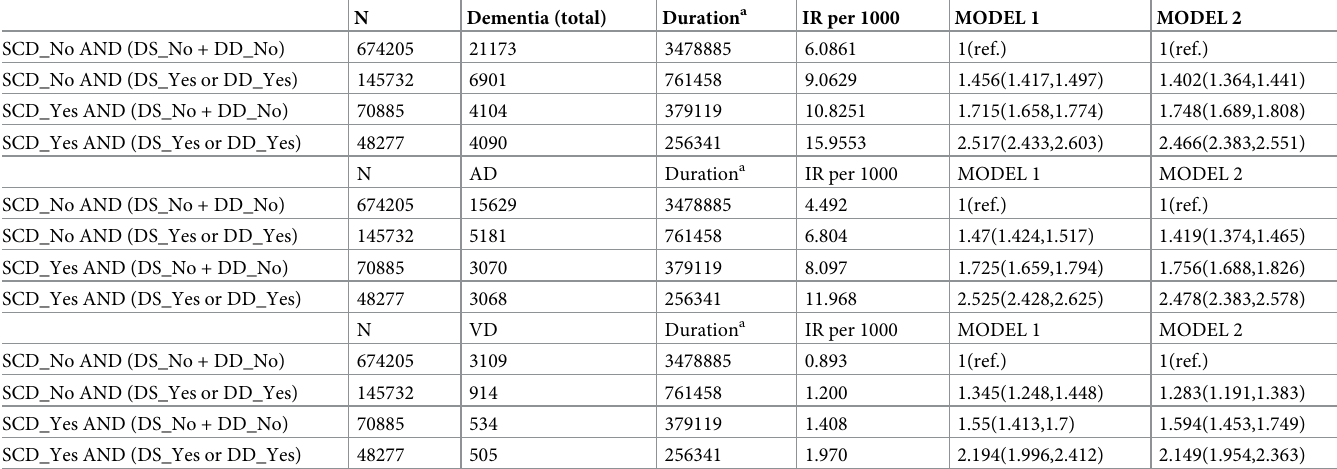
Our findings confirm those of previous studies that found the risk of total dementia, AD, and VD was higher in individuals with depression than in healthy control subjects [42–44]. By excluding patients with a history of depressive disorder and including only patients with recent (within 12 months before study enrollment) depressive disorder, we were able to more pre- cisely show that recent late-life depression is associated with an increased risk of subsequent dementia. Although previous studies have shown that the risk of dementia is higher in patients with SCD [17,45], only one large cohort study by Liew et al., [29] which included 13,462 Table 4. Combined risk of total dementia due to depressive symptom, depressive disorder history, and subjective cognitive decline. N Dementia (total) Duration a IR per 1000 MODEL 1 MODEL 2